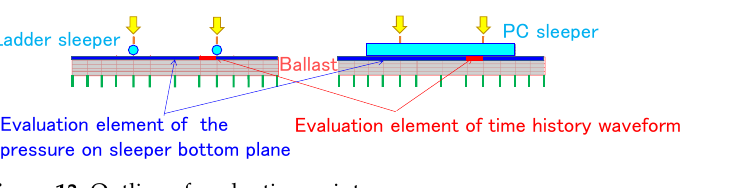
Figure 13. Outline of evaluation point.